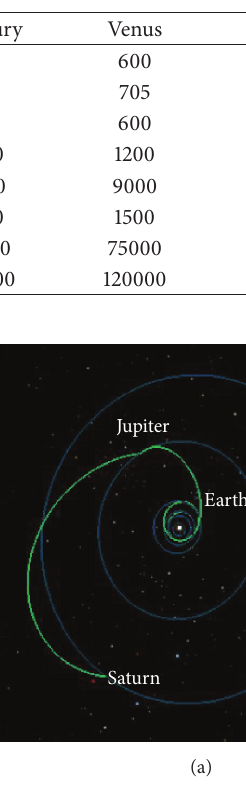
Table 16: The maximum transfer duration between random two planets.